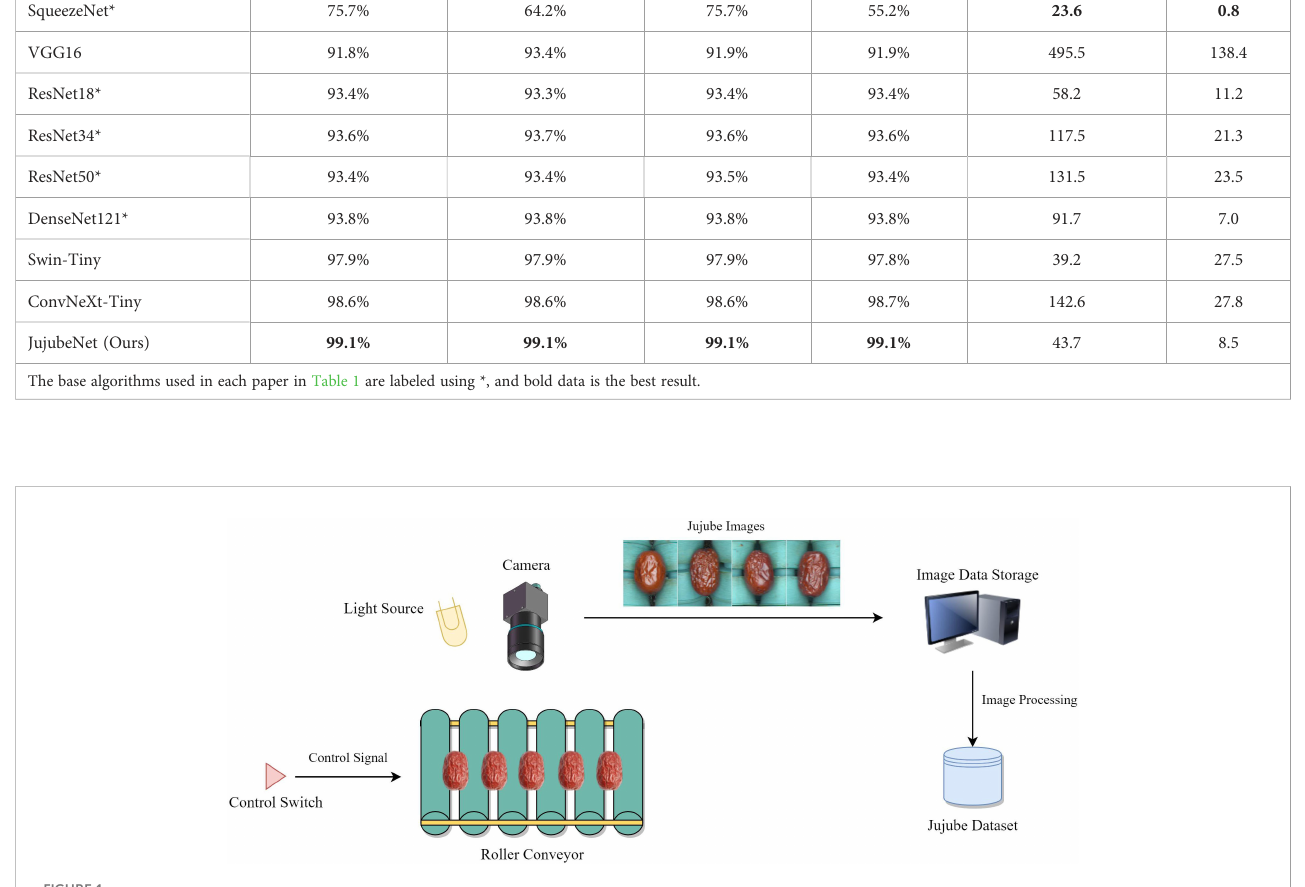
FIGURE 1 Work fl ow diagram of ‘ Jujube2000 ’ data set collection